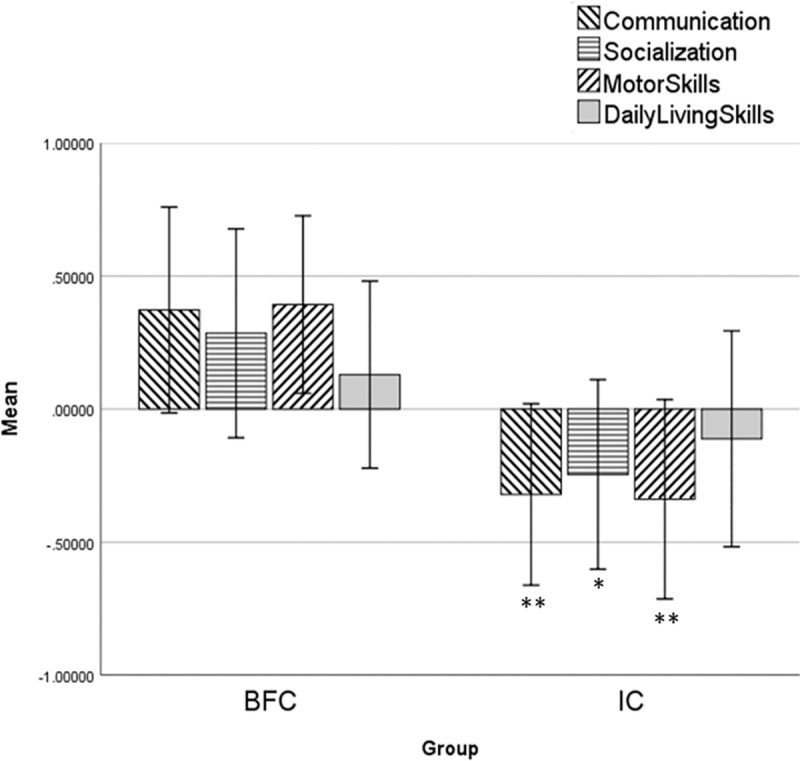
Barplots of average Z-scores for the four VABS adaptive behavior domains.*—denote significant between-group differences at *p < .05 and **p < .01. Means and standard deviations are shown.